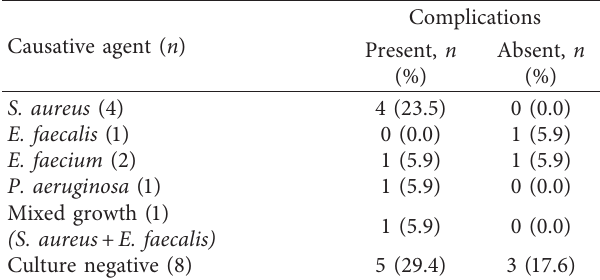
Table 6: Complications of patients with respect to the causative agents of IE ( n �